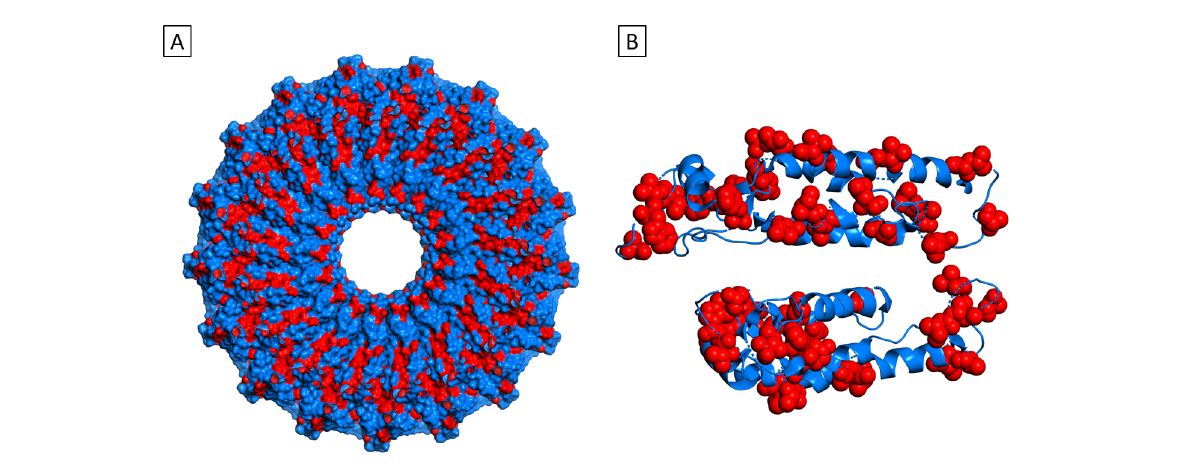
Figure 6: PyMOL [47] schematic showing (A) one face of the disk and (B) the side view of two layers of the disk. Hydrophobic residues are coloured in red. Alcohols may be replacing or strengthening protein–protein interactions between the faces of the disks, preventing helical-rod formation. Based on PDB